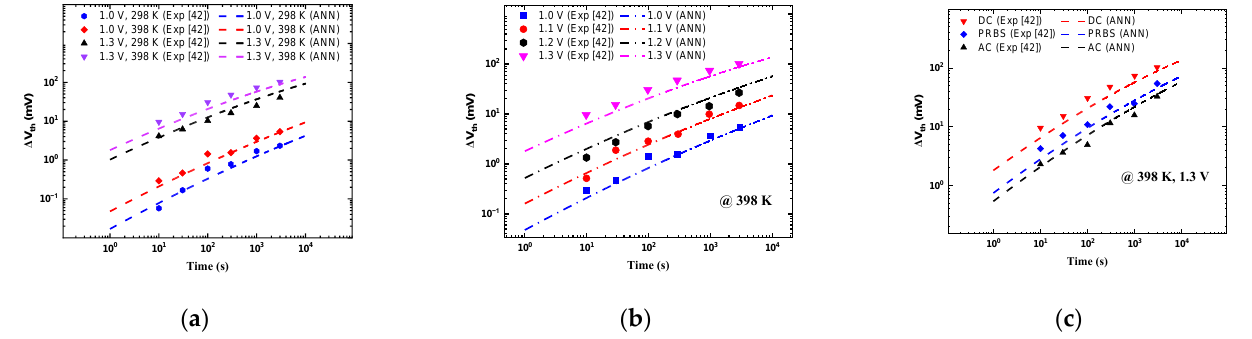
Figure 11. The comparison between ANN results (dot line) and experiment data (symbol) [42]. ( a ) TVS under different environment temperatures; ( b ) TVS under stresses with different voltage amplitude; ( c ) TVS under stresses with different waveforms (DC, 5 GHz AC and 5 GHz PRBS) [33].